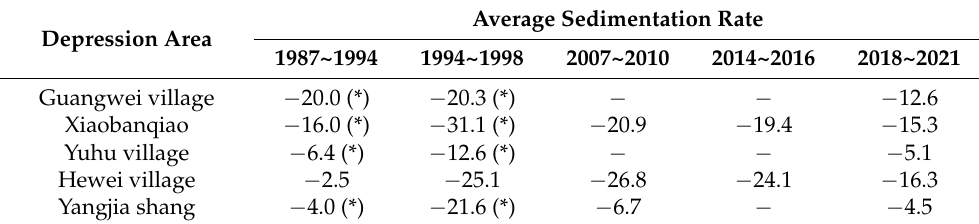
Table 8. Subsidence rates of the study area at different times.